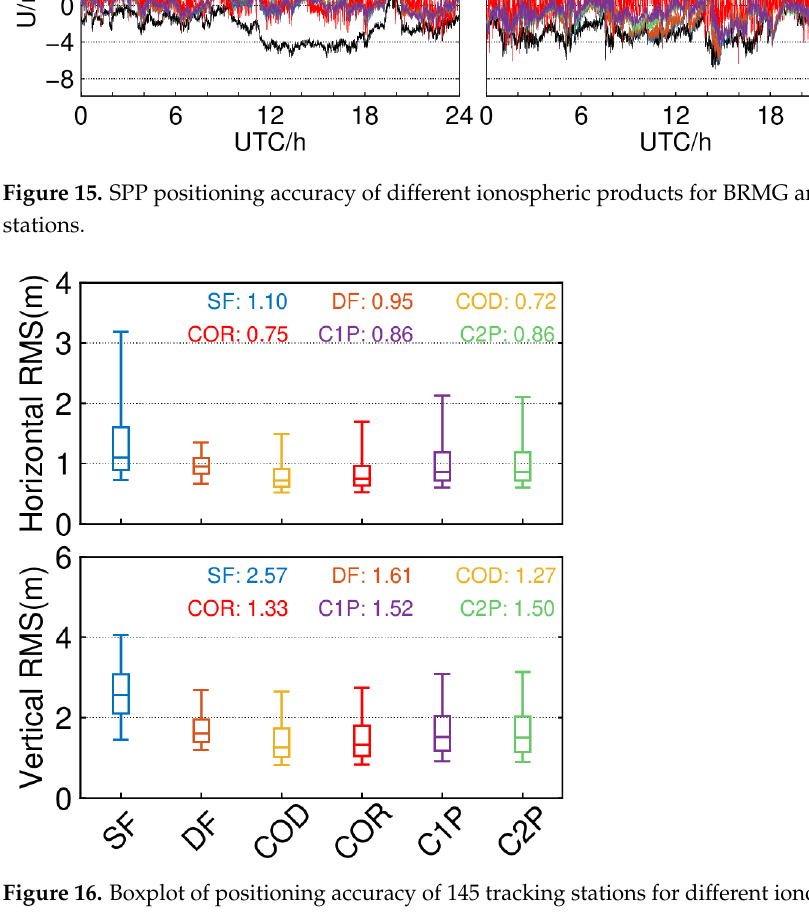
Figure 15. SPP positioning accuracy of different ionospheric products for BRMG and ABPO tracking stations.